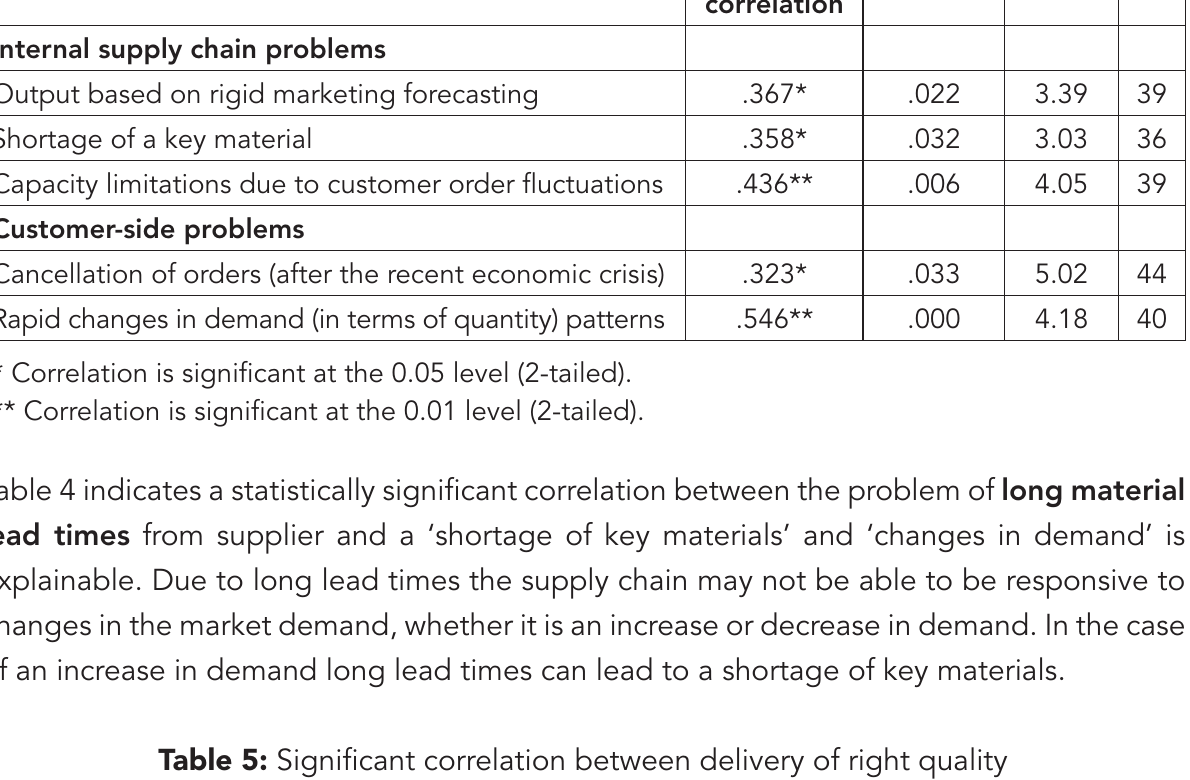
Table 5: Significant correlation between delivery of right